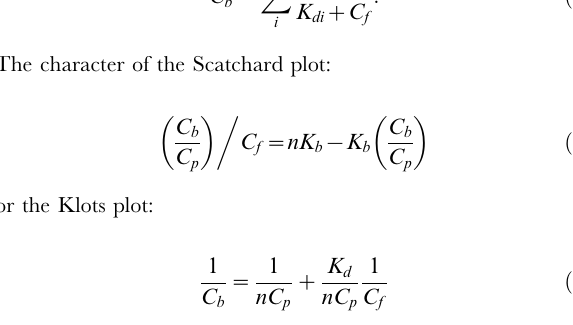
Table 1. Characteristics of thioflavin T bound to amyloid fibrils, acetylcholinesterase and free dye in water solution.